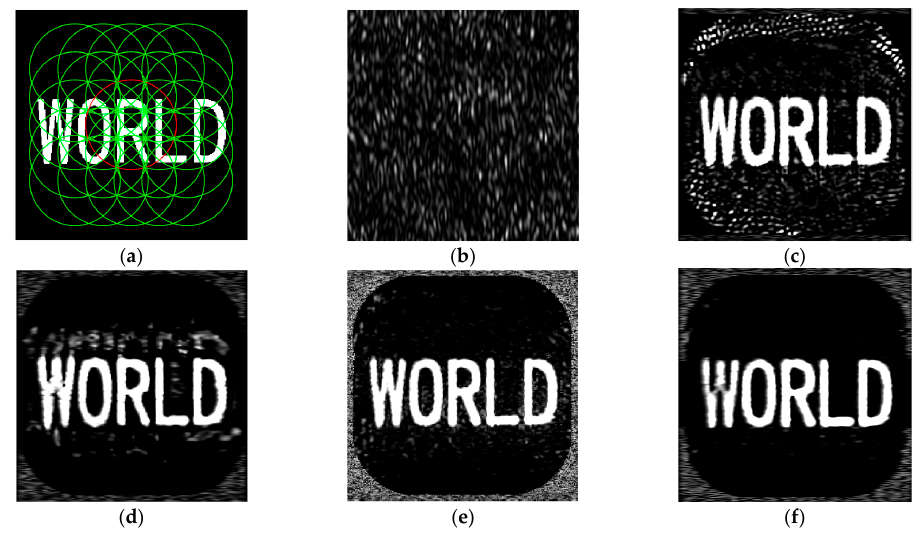
Figure 12. ( a ) Ptychographic measurements for the original object. ( b ) One of the measured speckle patterns for the center aperture (red circle area (a)). ( c ) The reconstruction results for the error reduction (ER) algorithm. ( d ) The reconstruction results for the Wirtinger flow (WF) algorithm. ( e ) The reconstruction results for the amplitude flow (AF) algorithm. ( f ) The reconstruction results for the proposed amplitude flow regularization by denoising (AF-RED) algorithm.